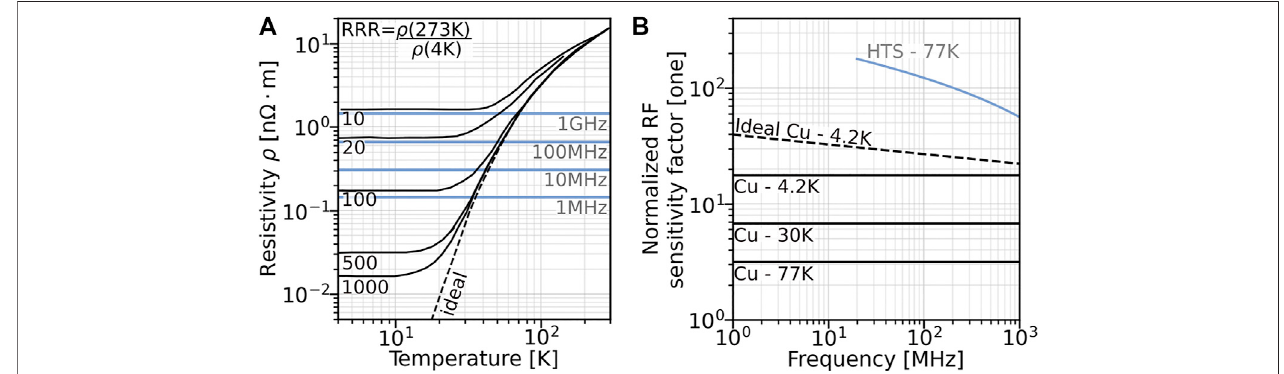
FIGURE 1 | (A) Expected resistivity ρ of copper at low temperature theoretically computed from [20], (black) and expected frontiers, i.e. α ( ρ , ω ) (cid:2) 1, (blue) below which the anomalous skin effect is no longer negligible compared to the skin effect. (B) Corresponding RF sensitivity factor, in the case of a lossless sample, using a cooled copper coil (black) with RRR (cid:2) 20 at different temperatures or a HTS coil (blue) at 77 K {data interpolated from [21]}, normalized by the sensitivity factor of the same copper coil at room temperature. The dashed line corresponds to the ultimate surface resistance achievable with absolutely pure copper, accounting for the anomalous skin effect [ α ( ρ , ω ) → ∞ ]. The effect of the static magnetic fi eld on the HTS coil, not taken into account here, can signi fi cantly reduce these